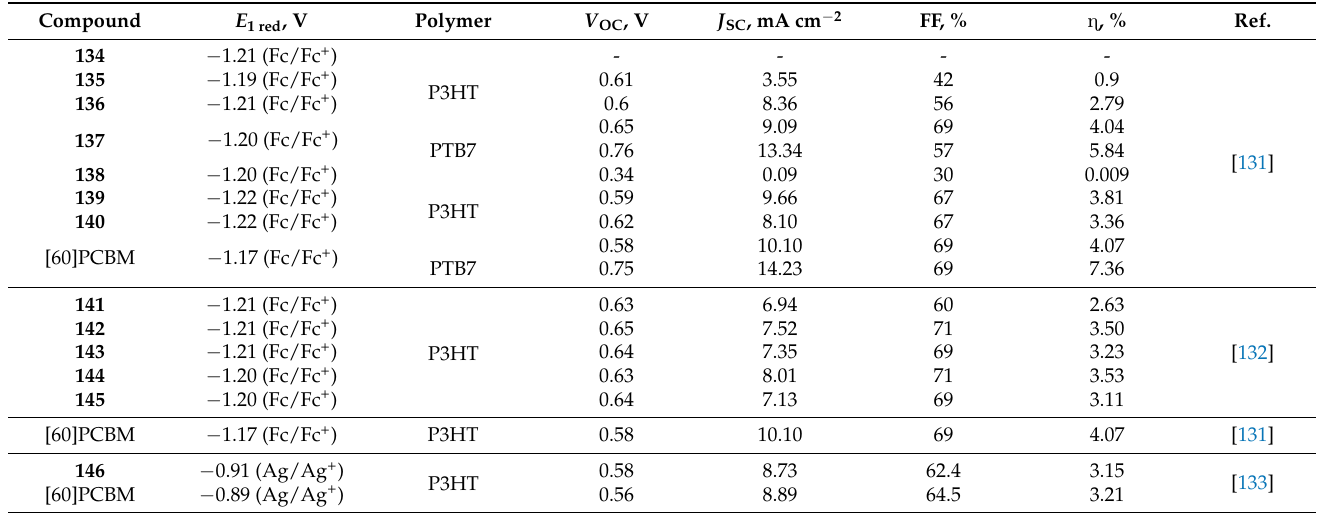
Table 3. The first reduction potentials and characteristics of the solar cells based on the cyclohexane fullerene